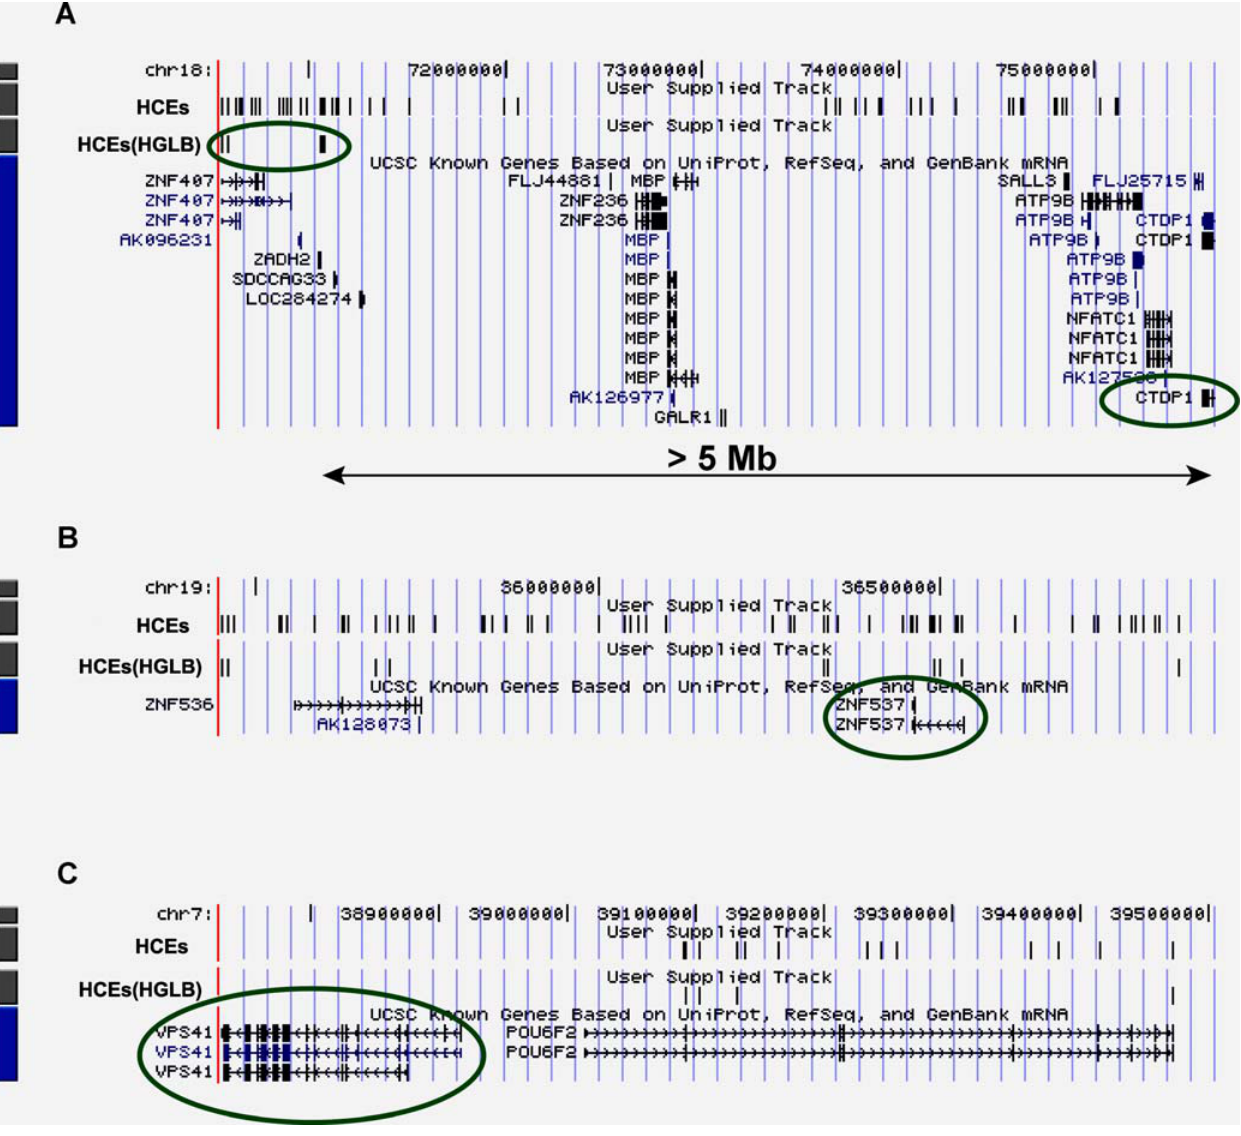
Figure 2. Human genomic environment of the three cases in which multi-HCEs are associated with only one gene. The three genes are all ‘‘trans-dev’’ associated, and labeled with surrounding oval. A: Six HCEs clustered in a 0.5 Mb region are linked with the disease-associated gene CTDP1 . The CTDP1 gene and the six HCEs are located more than 5 Mb apart. B: Thirteen HCEs are associated with the single gene TSHZ3 (ZNF537). C: Five HCEs are linked with the gene VPS41 .